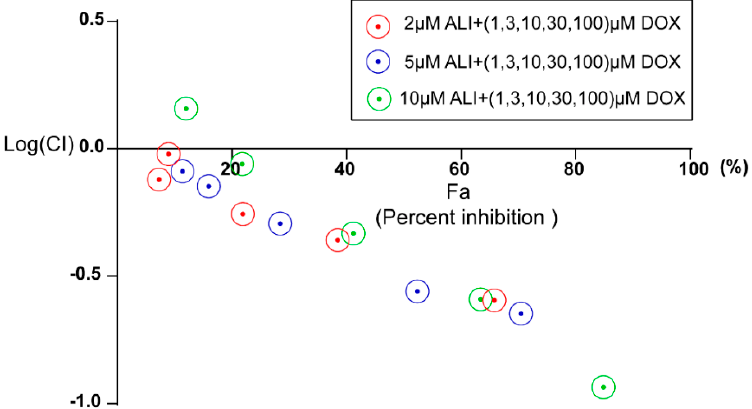
Figure 6. Combination index of different cell inhibition rate. Fa, the abbreviation of fraction affected, serves as the percent cell inhibition and CI represents combination index. The concentrations used for doxorubicin was 1, 3, 10, 30, 100 μ M and that of ALI were 2, 5, 10 μ M.